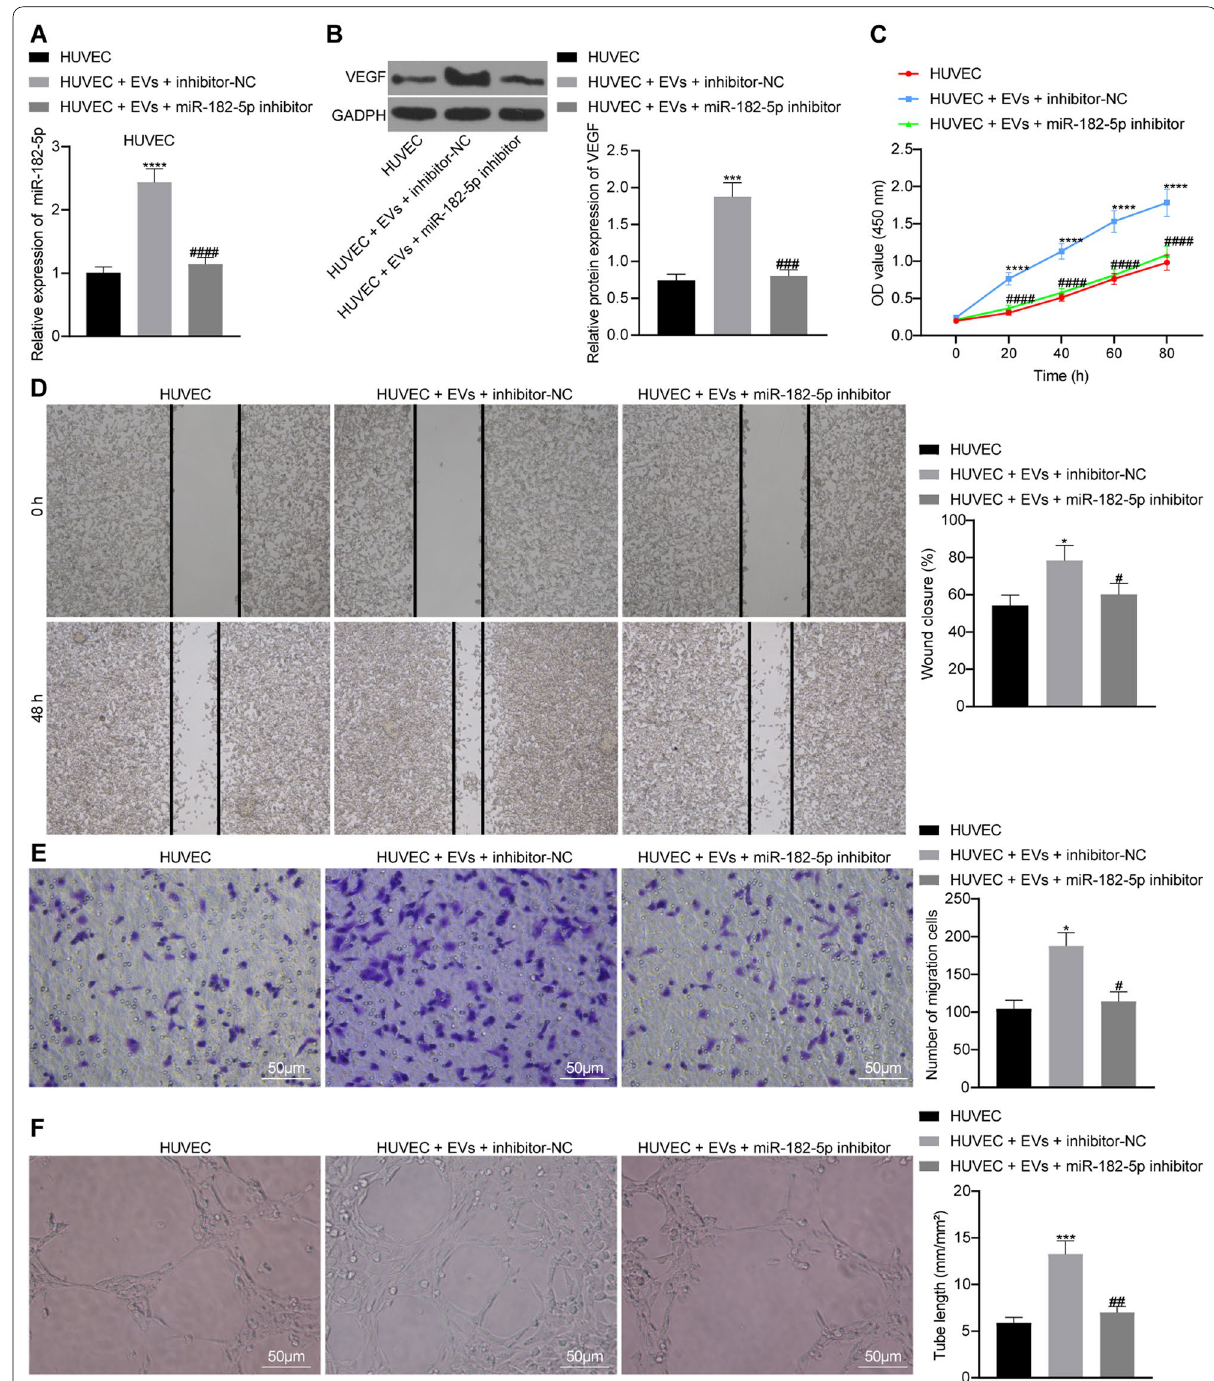
Fig. 4 EVs-miR-182-5p exerts promoting effects on HUVECs proliferation, migration and angiogenesis. HUVECs were treated with EVs miR-182-5p + inhibitor. A miR-182-5p expression of HUVECs detected by RT-qPCR, the statistical power was 1; B VEGF protein expression of HUVECs detected by Western blot analysis, the statistical power was 1; C The proliferation of HUVECs detected by CCK-8 assay, the statistical power was 1; D Migration ability of HUVECs detected by scratch test, the statistical power was 1; E Migration ability of HUVECs detected by Transwell assay, the statistical power was 1; F Vessel-like tube formation in vitro of HUVEC, the statistical power was 1. * p < 0.05, *** p < 0.001, **** p < 0.0001 compared with HUVEC; # p < 0.05, ## p < 0.01, ### p < 0.001 compared with HUVEC treated with EVs inhibitor NC. The experiment was conducted three times +